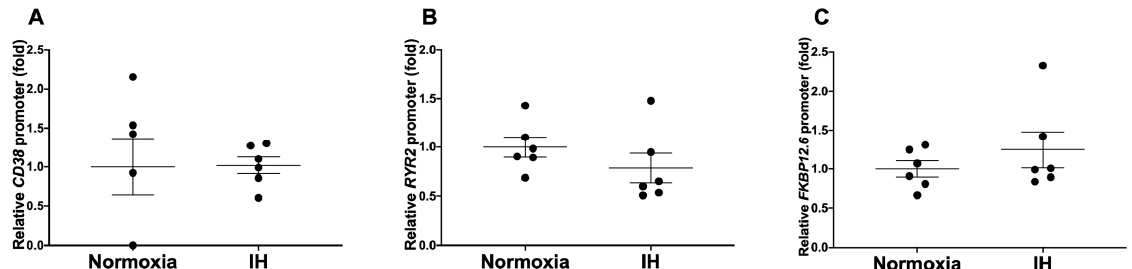
Figure 4. Luciferase assays of the promoter activities of ( A ) CD38 , ( B ) RYR2 , and ( C ) FKBP12.6 in H9c2 cardiomyocytes. Reporter plasmids, prepared by inserting the promoter fragments of human CD38 ( − 3187~+269), human RYR2 ( − 1250~+10), and human FKBP12.6 ( − 1696~+109) upstream of a firefly luciferase reporter gene in pGL4.17 vector, were transfected into rat H9c2 cells. After the cells were exposed either to IH or to normoxia for 24 h, the cells were lysed and the promoter activities of CD38 , RYR2 , and FKBP12.6 were measured. The promoter activity was normalized for variations in transfection efficiency, with β -galactosidase activity as an internal standard and the promoter activity of cells exposed to normoxia was set to 1.0. Data are presented as the mean ± SE of the samples ( n = 5 to 6) and were analyzed using Student’s t